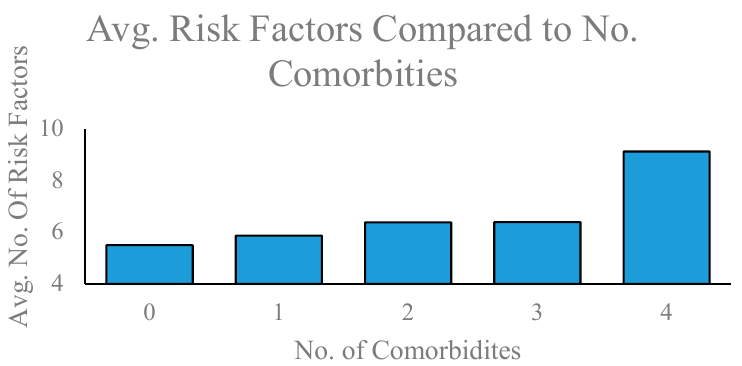
Figure 1. Average number of comorbidities and risk and adversity factors compared to the severity of ADHD Symptoms. Severity of ADHD symptoms measured on the X-axis and mean number of comorbidities and average number of risk and adversity factors measured on the Y-axis.